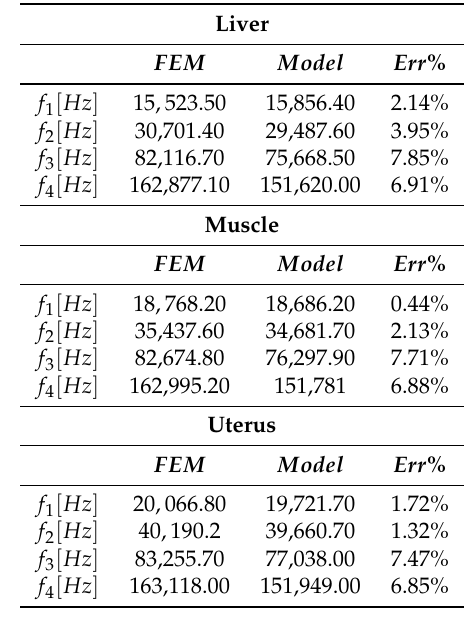
Table 3. Comparison between the eigenfrequencies obtained by the COMSOL FEM code and the proposed